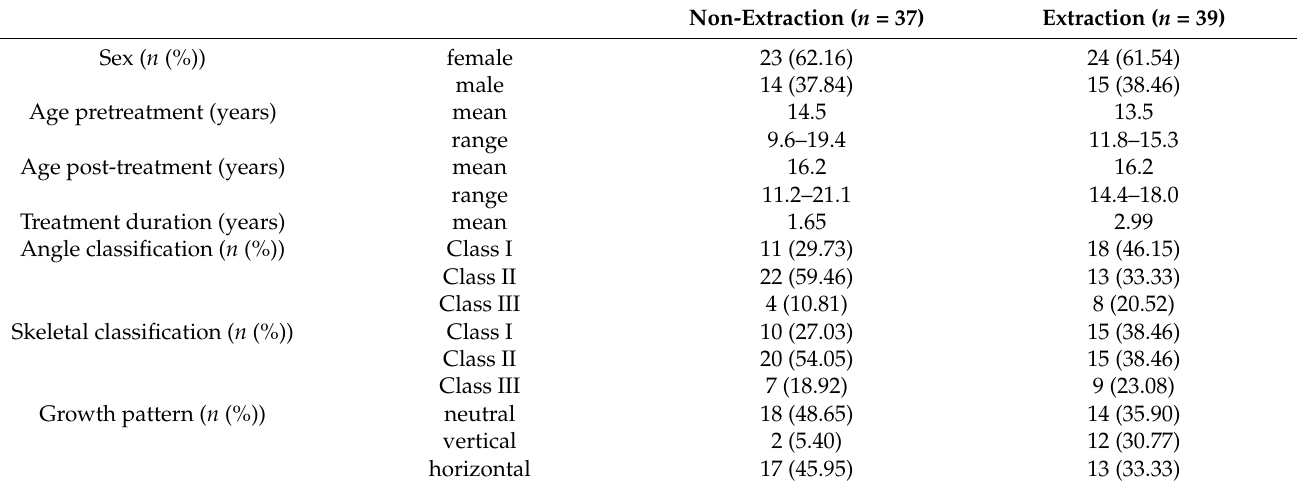
Table 1. Patients’ distribution in extraction and non-extraction groups according to sex, age, treatment duration, Angle classification, skeletal classification, and growth pattern.